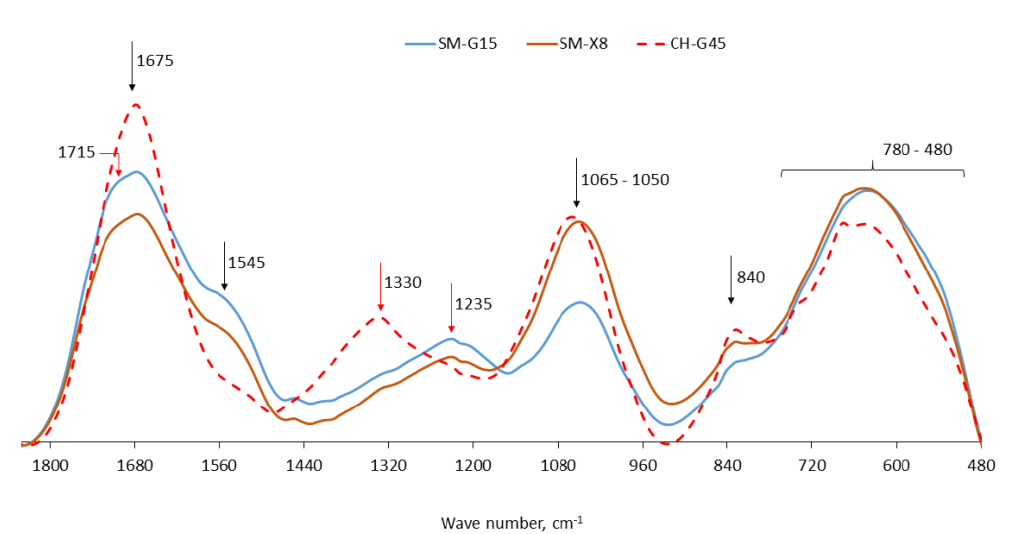
Figure 5. Total area-normalized FTIR spectra in the 1800–480 cm − 1 region of EPS produced by cultivation of B. atrophaeus BU4 in glucose- (SM-G15) and xylose-based (SM-X8) synthetic media and in a quinoa stalk cellulosic hydrolysate (CH-G45). Black arrows indicate peaks that are common for all EPS preparations, and red arrows indicate peaks that are specific for some